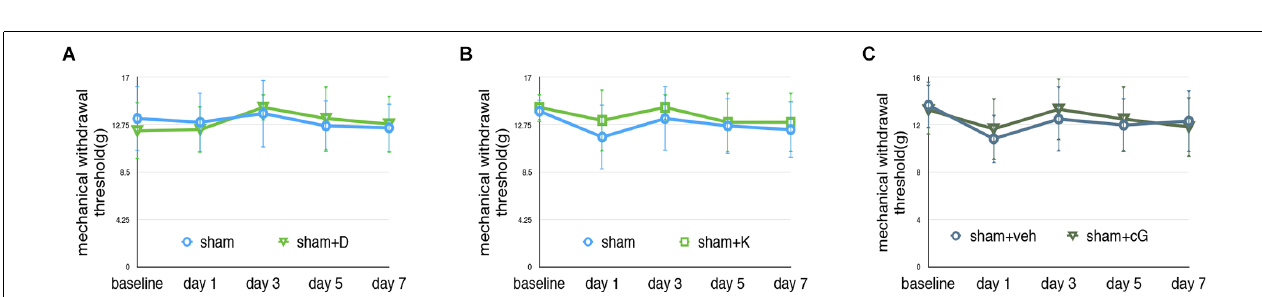
FIGURE 4 | Effects on pain behavior test following dexmedetomidine or ketamine administration. (A) MWT of sham and sham+D groups, sham: sham of SNL groups; sham+D: sham+dexmedetomidine administration group. (B) MWT of sham and sham-K groups, sham: sham of SNL groups; sham-K: sham+ketamine administration group. There were no significant changes in sham+D/sham+K compared to the sham group. (C) MWT of the sham and sham+cG group. There were no significant changes between the sham and sham+cG group ( N = 4, two-way ANOVA, P > 0.05).